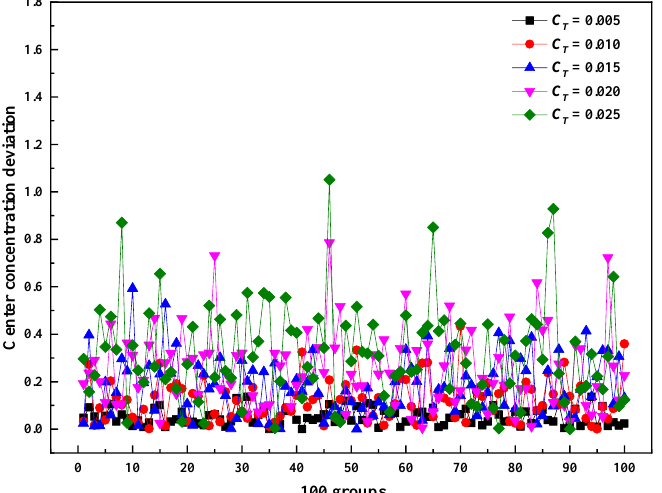
Figure 5. Center concentration deviation under different relative standard deviations of temperature at mean temperature 543 K.